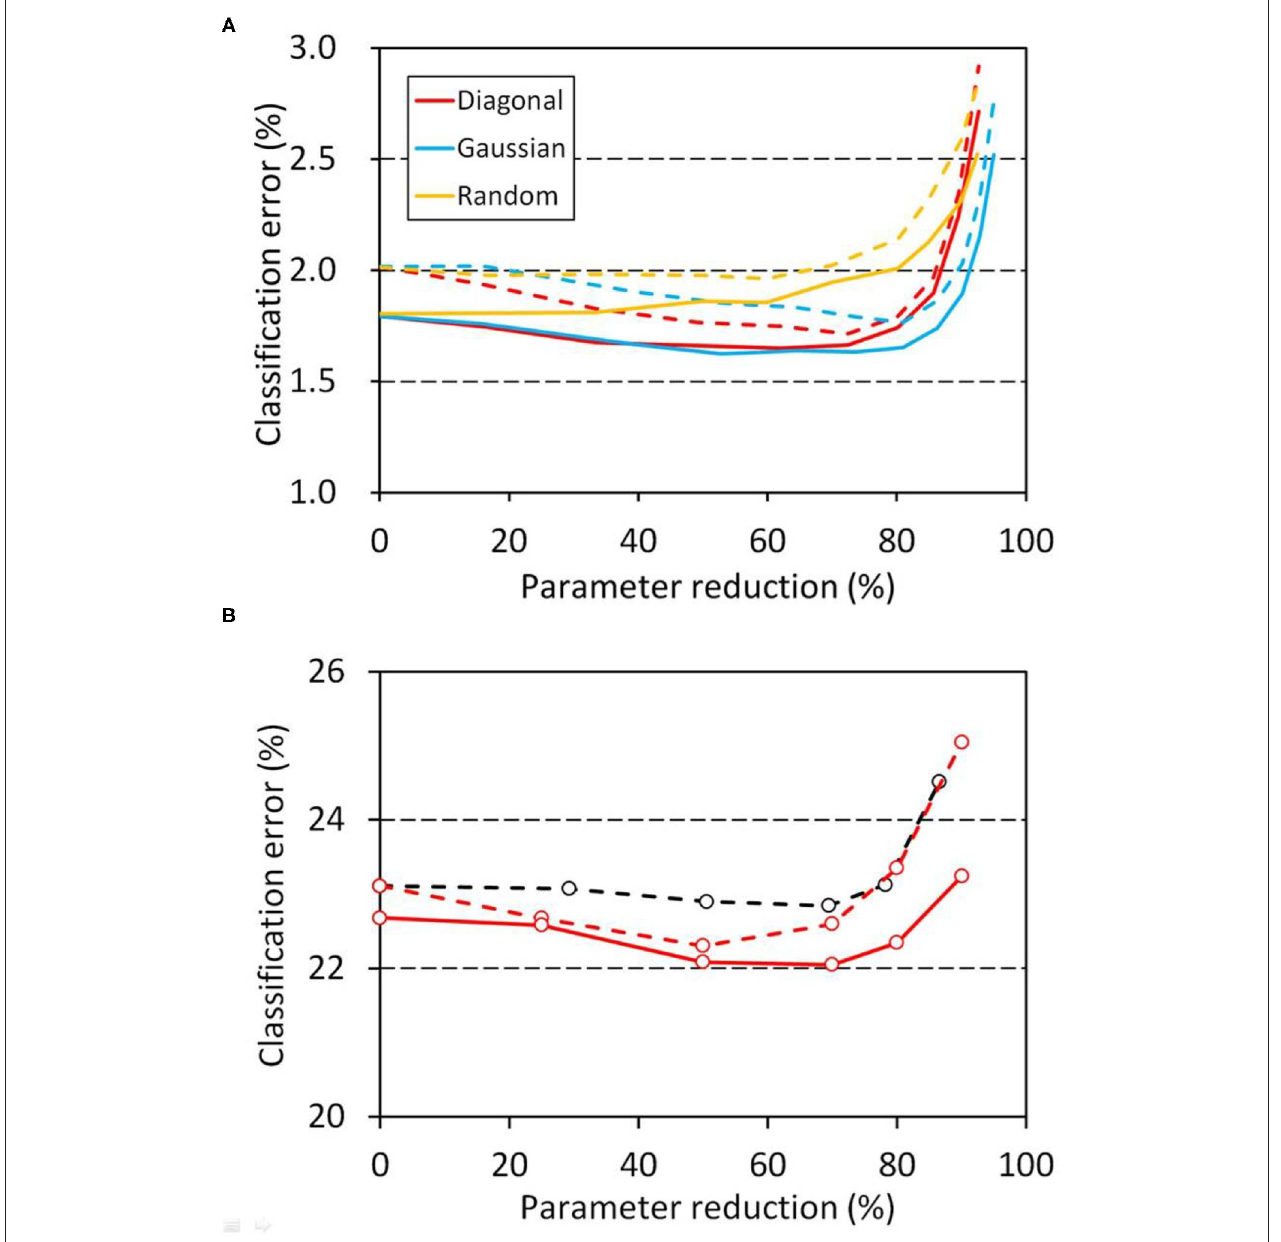
FIGURE 6 | Relation between error and parameter reduction in the developmental model, in which the weights of the schizophrenia connection layers were masked with a window throughout the training and evaluation. The left intercepts correspond to a network with fully connected layers. (A) MNIST classification using network A ( Table 1 ). Training and evaluation were repeated for 100 sessions, and their mean classification errors are plotted. Errors at 10 epochs are plotted with dashed lines and errors at 50 epochs with solid lines. (B) CIFAR-10 classification using network C ( Table 1 ). Training and evaluation were repeated for 10 sessions, and their mean errors are plotted. A diagonal window was used in this task. Errors after 50 epochs are plotted with red dashed lines and errors after 75 epochs with red solid lines. The same classification task was also performed with conventional L 1 regularization for 10 sessions, and the resultant mean errors after 50 epochs are plotted with black dashed lines. Weights less than 0.0001 were regarded as zero in the reduction ratio